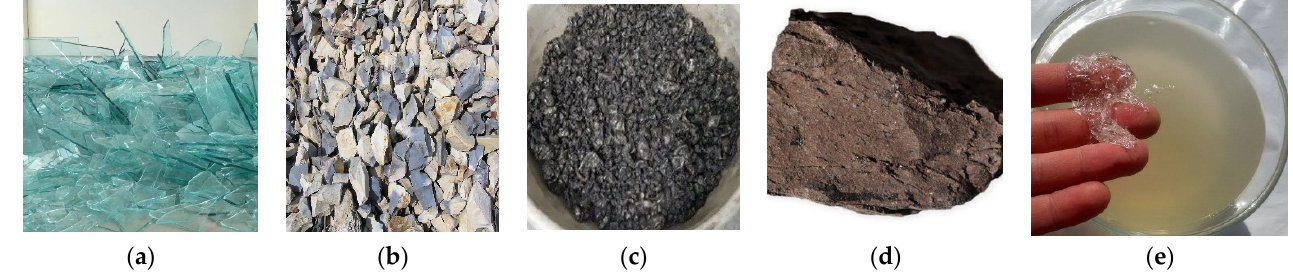
Figure 1. Appearance of the raw materials used: ( a ) glass breakage, ( b ) opoka, ( c ) WMS, ( d ) lignite clay, ( e ) liquid glass. Table 1. Chemical composition of the used raw materials, %.